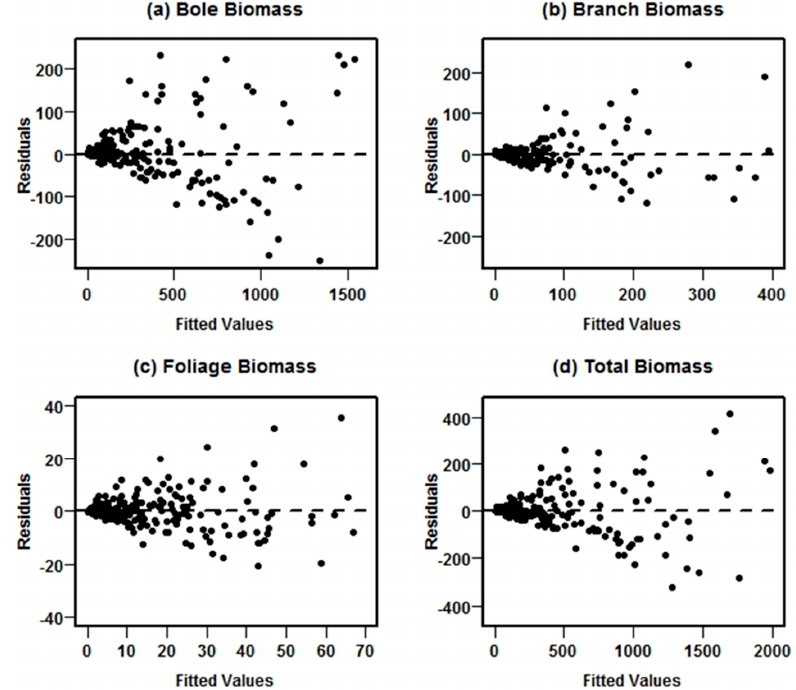
Figure 3. Residual plots for each biomass component in the model system II fitted using NSUR without weight function, showing significant heteroscedasticity.